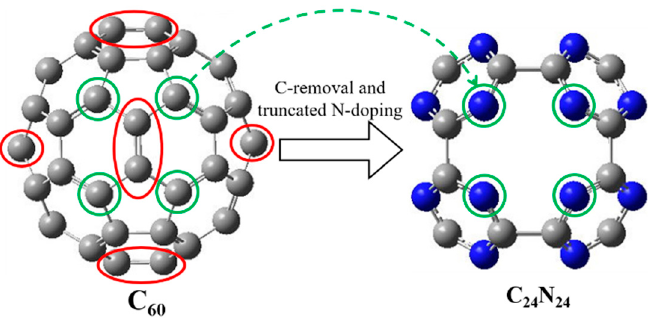
Figure 1. The optimized structure of porous C 24 N 24 originated from fullerene. Color code: C, gray; N, blue. N,